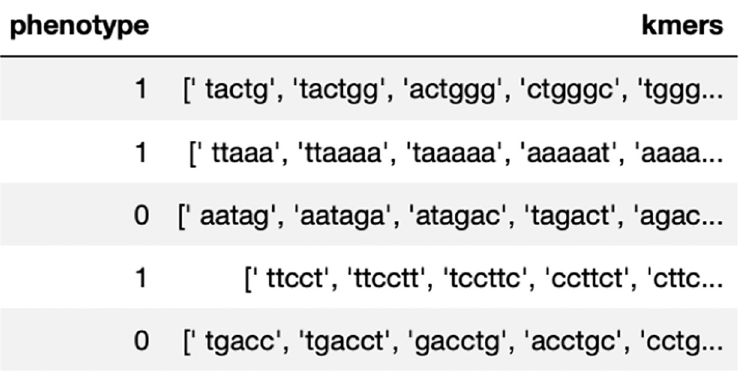
Fig 1. Blood DNA sequences x transformed into k -mers with their corresponding Gleason grade group y .